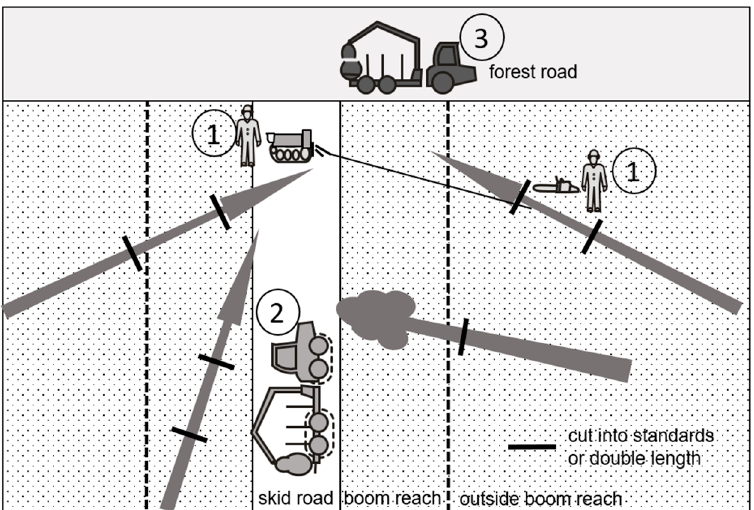
Figure 2. Operational setup of the simulated ground-based system: working steps include (1) motor-manual felling and de-limbing, assisted by mini forest crawler, (2) extraction of full trees by combi-forwarder to skid road, and (3) final extraction to landing.